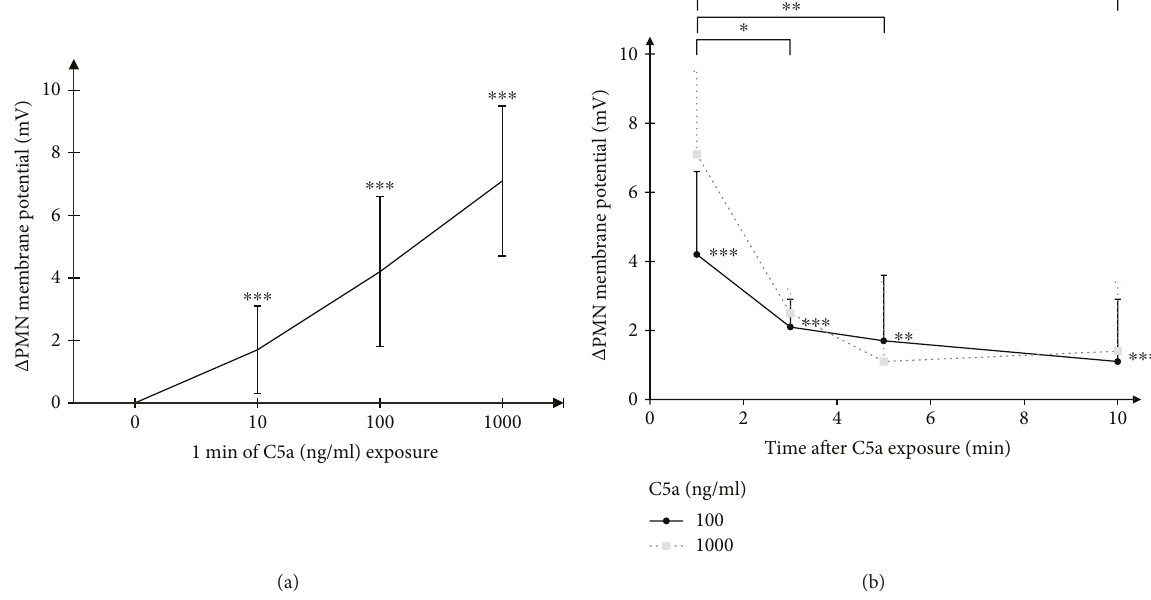
Figure 2: (a) Concentration dependency. Concentration-dependent change in resting membrane potential in human neutrophils after incubation with C5a demonstrating a depolarization in a dose-dependent manner ( n = 11 ; 45 ; 6 ). (b) Time dependency. Time-dependent change of resting membrane potential of human PMN after stimulation with C5a 100ng/ml (straight black line) and C5a 1000 ng/ml (gray dotted line), n =3 – 45. All signi fi cance indicators refer to C5a 100 ng/ml. ∗ p < 0 05 , ∗∗ p < 0 01 , and ∗∗∗ p < 0 001